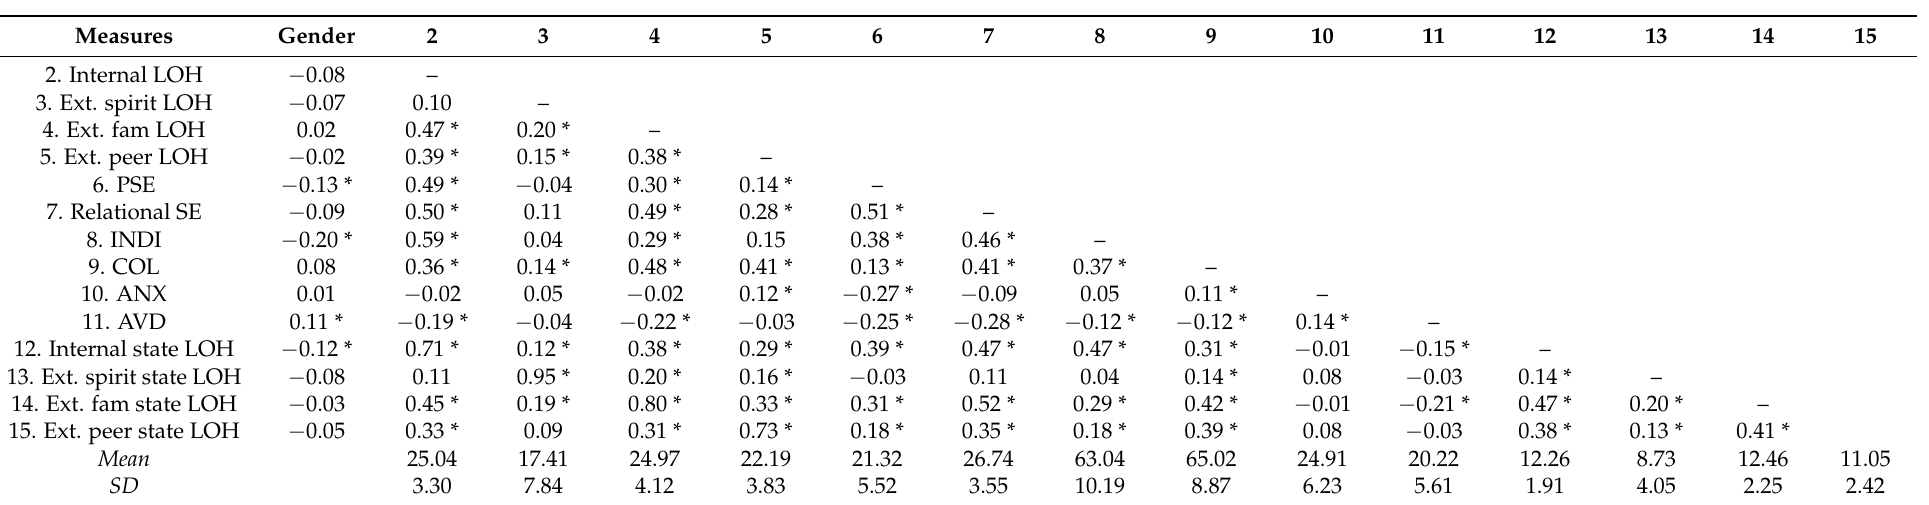
Table 1. Descriptive Statistics and Correlations of Variables of